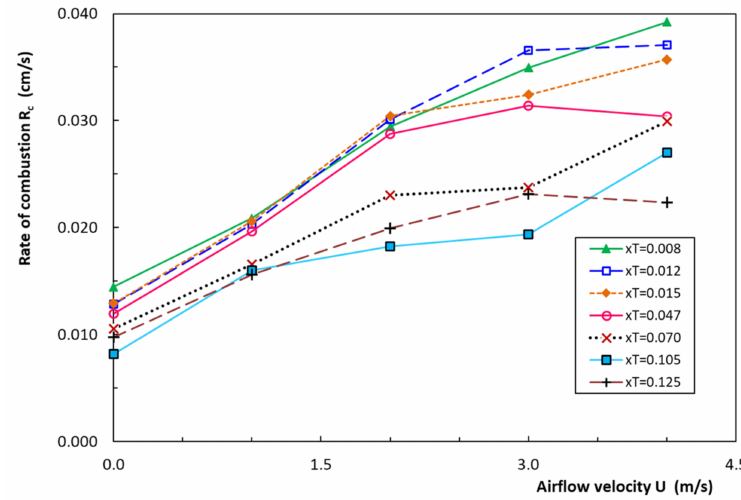
Figure 6. Rate of combustion of lower ignition propensity cigarettes as a function of flow velocity U (m.s − 1 ) for tests with inclination α = 0º and orientation ϕ = 0º, and different values of tobacco moisture content x T .